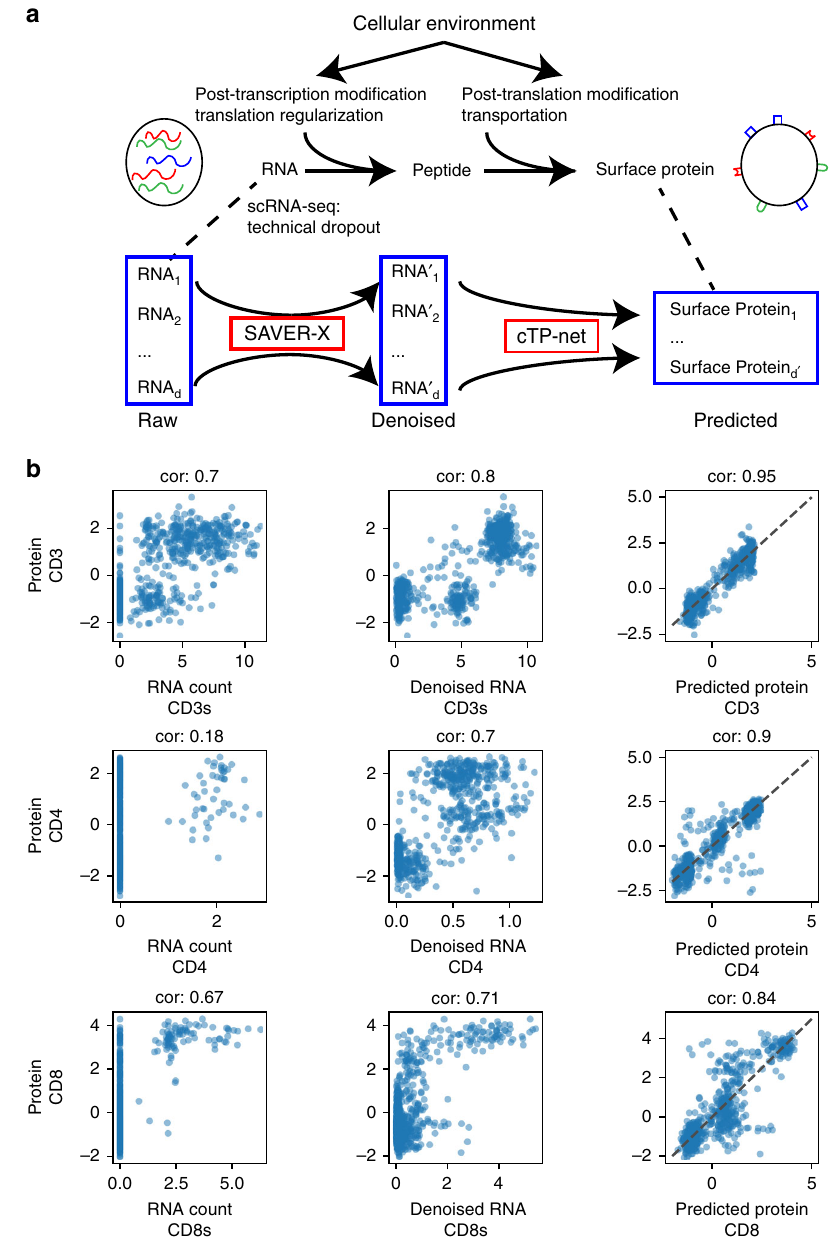
Fig. 1 cTP-net analysis pipeline and imputation of example proteins. a Overview of cTP-net analysis pipeline, which learns a mapping from the denoised scRNA-seq data to the relative abundance of surface proteins, capturing multi-gene features that re fl ect the cellular environment and related processes. b For three example proteins (CD3, CD4, and CD8), cross-cell scatter and correlation (cor) of CITE-seq measured abundances vs. ( 1 ) raw RNA count ( “ CD3s ” and “ CD8s ” are sum of all genes that compose proteins CD3 and CD8, see Supplementary Table 6), ( 2 ) SAVER-X denoised RNA level, and ( 3 ) cTP-net predicted protein